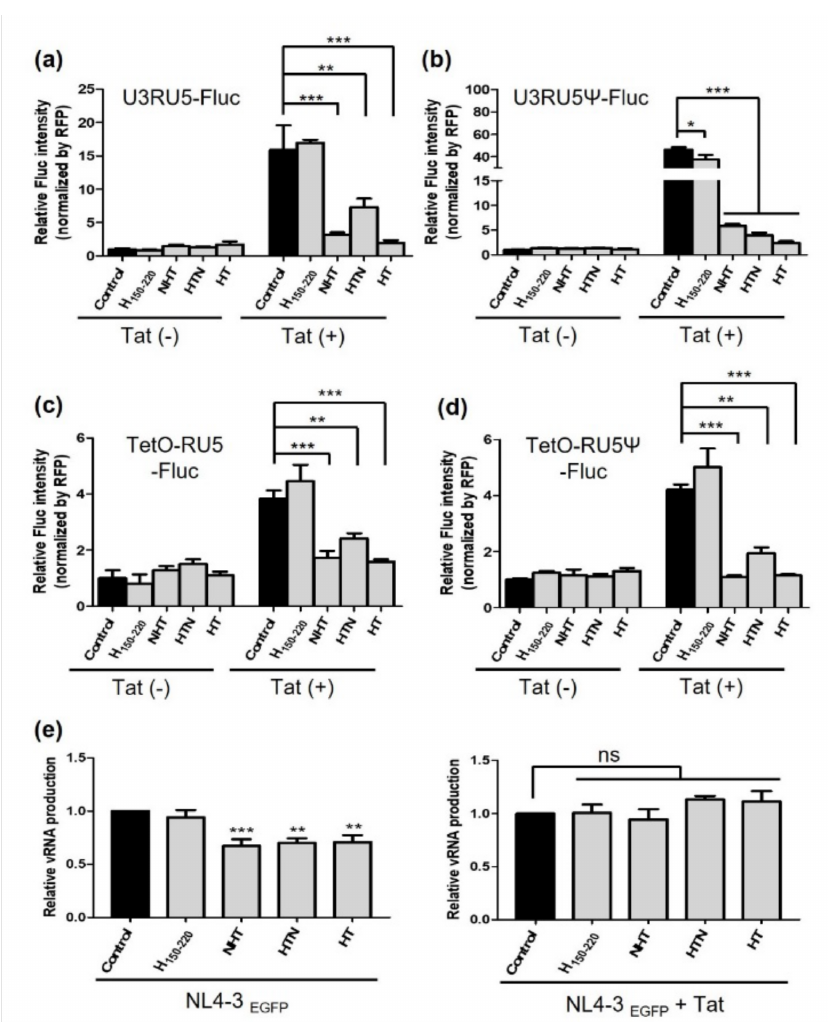
Figure 3. NHT, HTN and HT inhibited viral transcription in the presence of Tat. ( a , b ) HEK293T cells transfected with the empty vector; Myc-HEXIM1150-220; or Myc-tagged NHT, HTN, or HT with the reporter vector and RFP. Additionally, an expression vector for flag-tagged Tat was co-transfected a double the amount of the chimeric protein to confirm the effect of Tat. Twenty-four hours after transfection, cells were lysed in passive lysis buffer containing proteinase inhibitor cocktail and Fluc activity was measured ( n = 3). ( c , d ) Vectors with the TetO site were designed to regulate the transcription of the reporter gene using a tetracycline-inducible system. T-Rex 293 cells were also co-transfected in the same manner as HEK293T cells. Eighteen hours after transfection, reporter gene expression was induced with 1 µ g/mL tetracycline, cells were lysed and Fluc activity was detected 24 h after induction ( n = 3). U3RU5-Fluc ( a ), U3RU5 Ψ -Fluc ( b ), TetO-RU5-Fluc ( c ), and TetO-RU5 Ψ -Fluc ( d ) were used as reporter gene vectors. ( e ) HEK293T cells were co-transfected with Myc-tagged NHT, HTN, or HT and NL4-3EGFP with or without Tat. Twenty-four hours after transfection, RT-PCR was performed using primers complementary to Gag. Statistical signifi- cance was assessed using one-way ANOVA and Bonferroni’s multiple comparison test (* p < 0.05, ** p < 0.01, *** p < 0.005). NHT, NC-HEXIM1-Tat; HTN, HEXIM1-Tat-NC; Fluc, firefly luciferase;